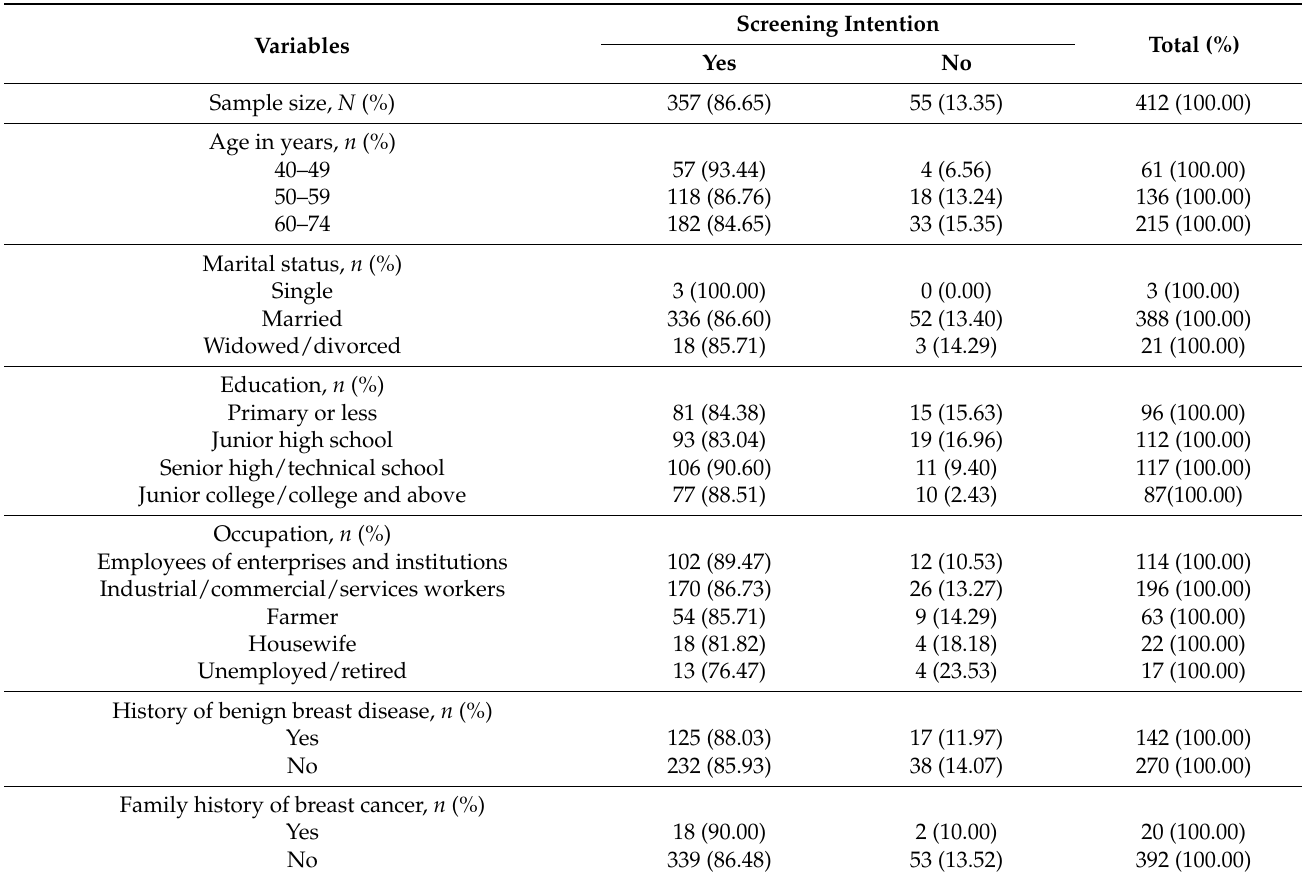
Table 1. Characteristics of the study